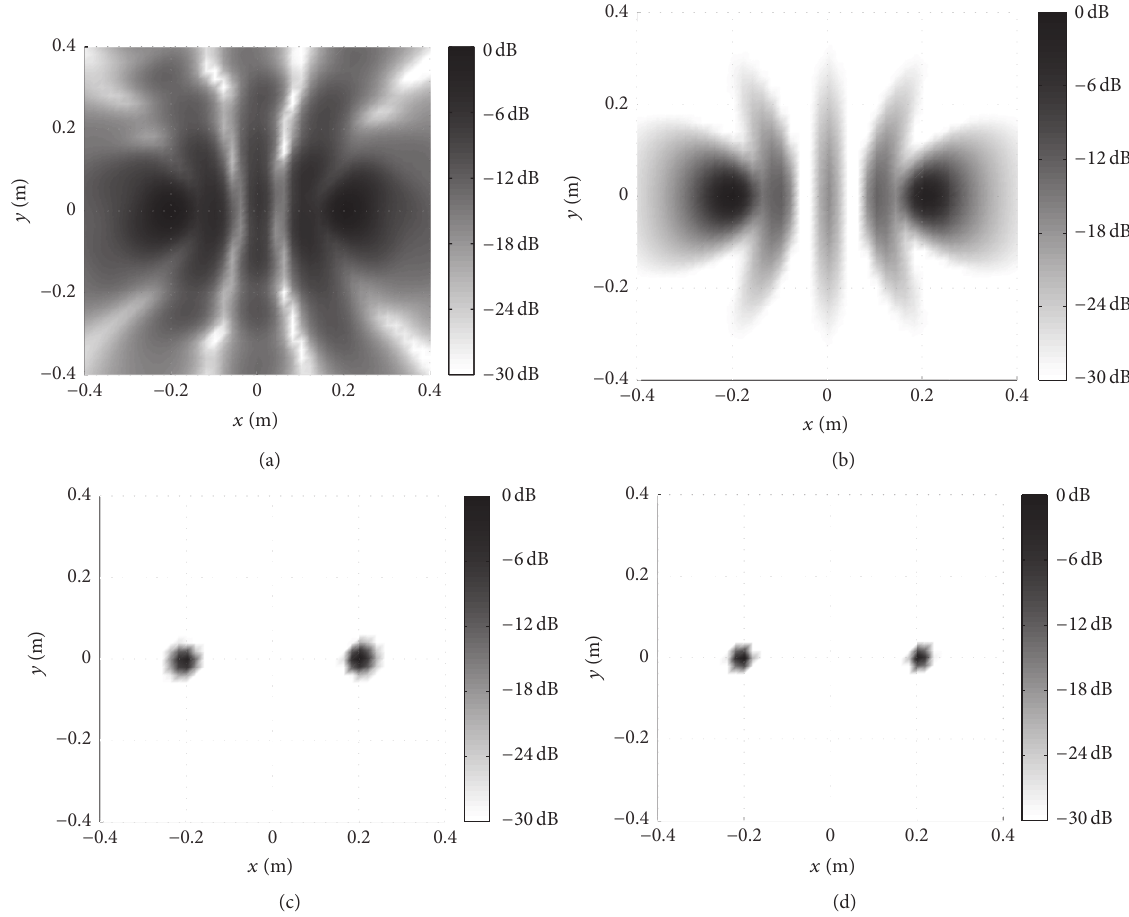
Figure 7: Noise source maps of coherent noise sources (1800Hz). (a) WBH. (b) iWBH. (c) IFESM, V = 2 . (d) IFESM, V = 6 .